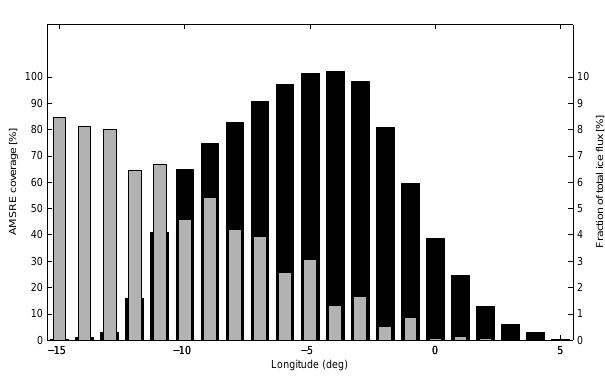
Fig. 6. Coverage of AMSR ice speed data along 79 ◦ N in the Fram Strait, contrasted with our new SAR based ice area export estimates. The period covered is October through April from 2004 to 2010. A 50% value (grey bars, left axis) means that the actual longitude bin has AMSR ice drift velocity estimates for 50% of the time. Black bars shows the contribution to the total ice flux for the individual longitude bins (right axis), calculated from the SAR ice drift veloc- ities for the same period. The SAR data coverage is 100% for all bins, i.e. we have an ice velocity measurement for every bin every 3